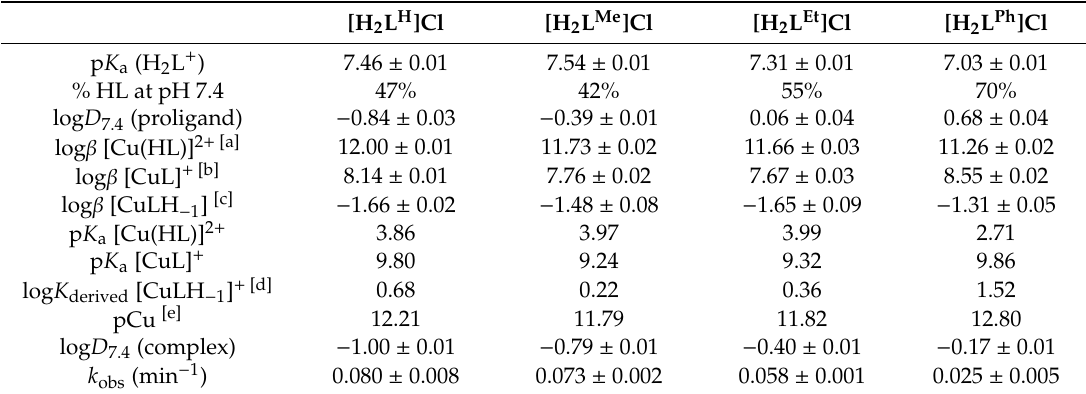
Table 2. Proton dissociation constants (p K a ) of the studied proligands; overall stability constants (log β ), p K a and derived constants (log K derived ) of their copper(II) complexes, pCu ( = − log[Cu(II)]) values calculated ( I = 0.1 M (KCl); t = 25 ◦ C), distribution coe ffi cients (log D 7.4 ) of the proligands and copper(II) complexes at pH 7.4, as well as the observed rate constants ( k obs ) for the redox reaction of the complexes with GSH (pH = 7.4; c complex = 25 µ M; c GSH = 1.25